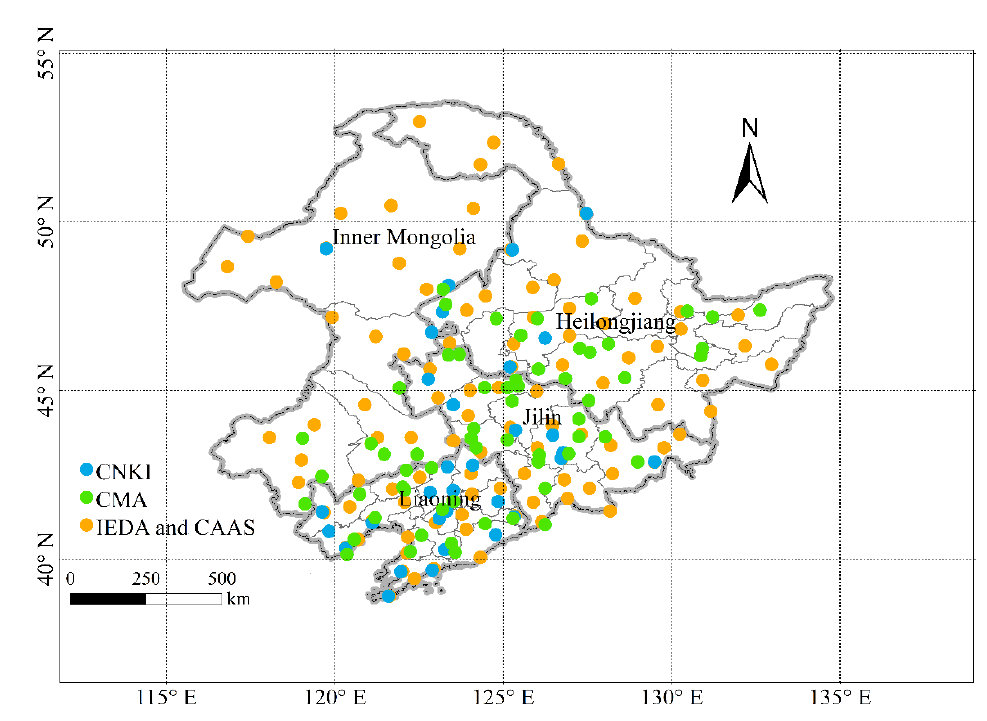
Figure 1. Spatial locations of the original maize phenological records obtained from three base data sets: CNKI, CMA, IEDA, and CAAS.